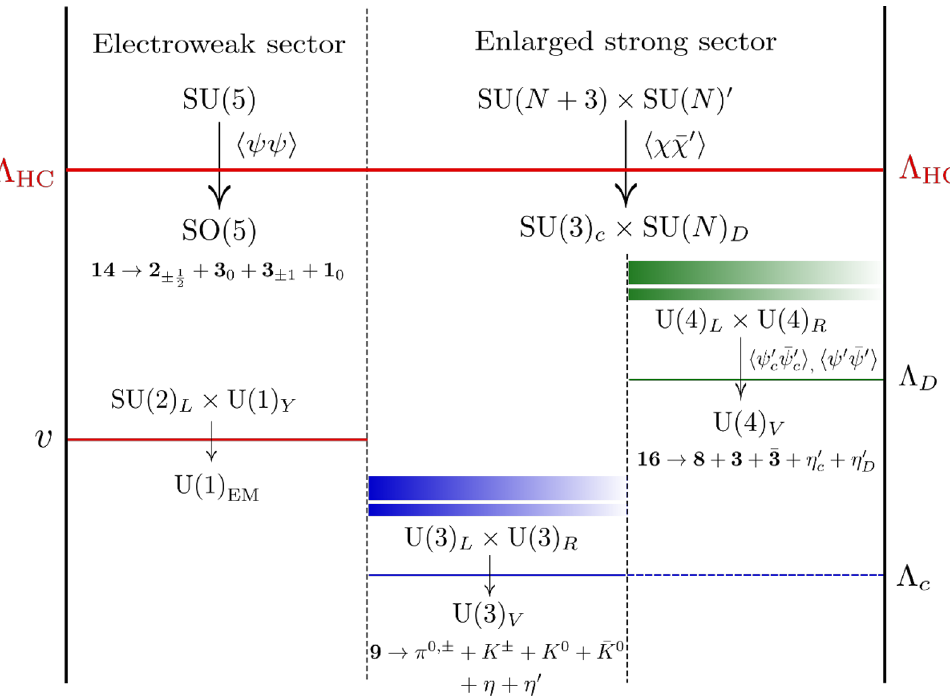
Figure 3. A schematic diagram showing all the relevant mass scales in the model. Both the electroweak and the enlarged strong sector contain fermions charged under the hypercolor group Sp (2 N HC ) . The green bands around Λ D indicate bound states of the diagonal color group SU ( N ) D , while the blue bands around Λ c represent the QCD bound states. The axions η 0 strong dynamics at Λ D